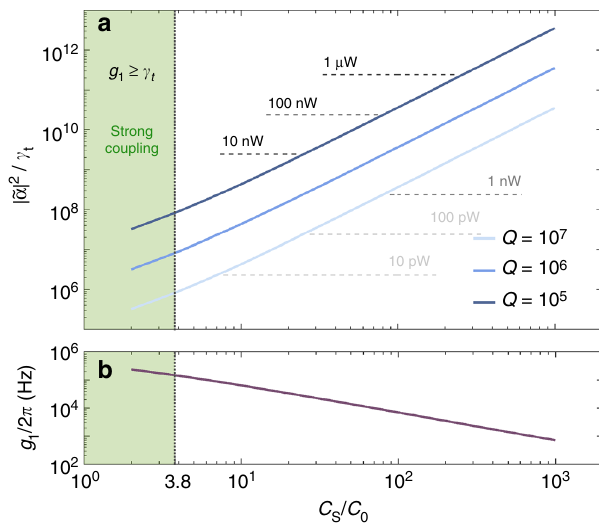
Fig. 4 Operating conditions in the presence of stray capacitances. required for the QND measurement, a Average intracavity photons ~ α j j 2 = γ t as a function of the relative value of the stray capacitance C s / C 0 . The three lines correspond to different values of the mechanical quality factor, as indicated in the legend. We assume Δ n b = 0.3 and equal contributions from ¼ (cid:2) N = 2 ¼ 3. As a the mechanical and electrically induced reservoirs (cid:2) n m eff reference, the grey dashed lines indicate the associated powers of the probe. b Linear coupling g 1 as a function of C s / C 0 . For both fi gures, the shadowed region indicates the strong coupling g 1 ≥ γ t , where QND detection is feasible with other approaches 26, 31,